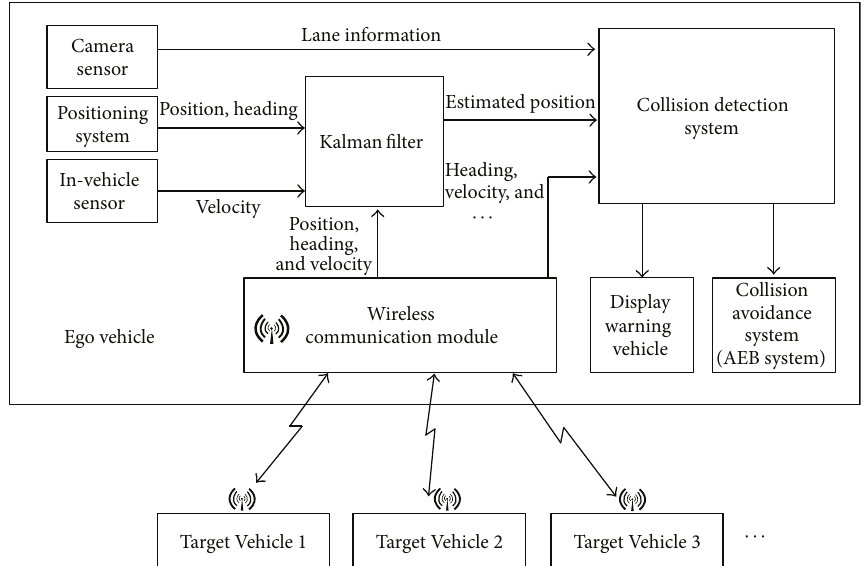
Figure 4: Block diagram of V2V communication-based AEB system.